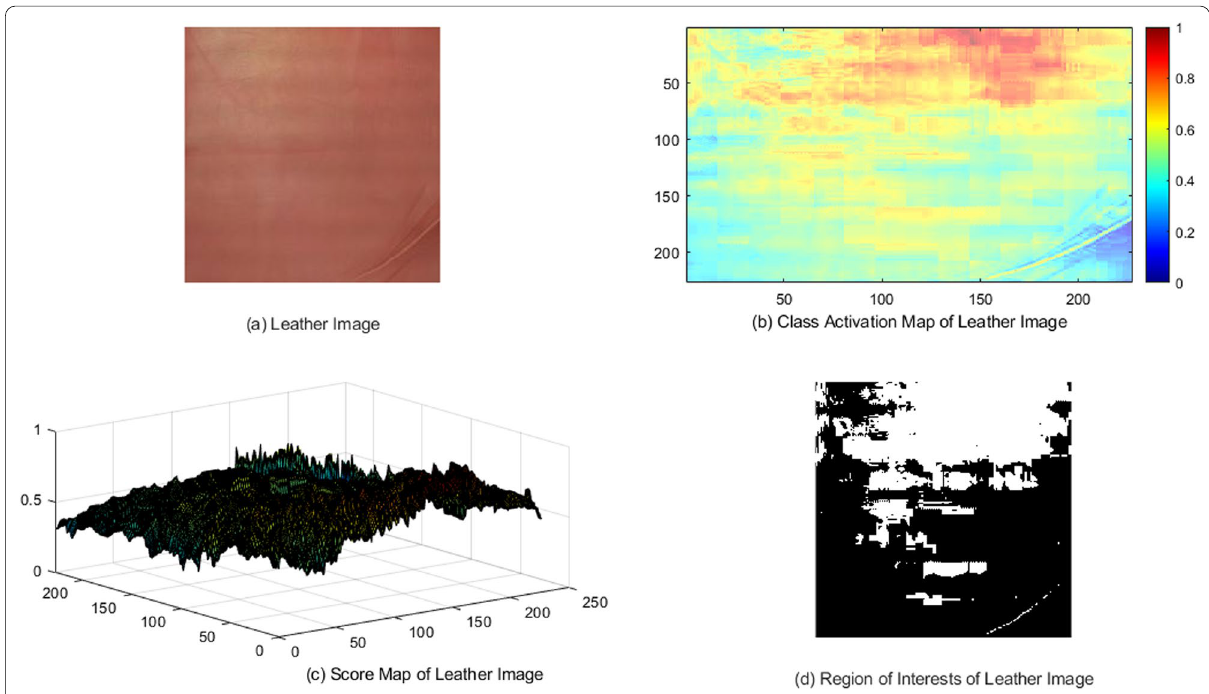
Fig. 15 Identified discriminative regions for different classes of the leather images using